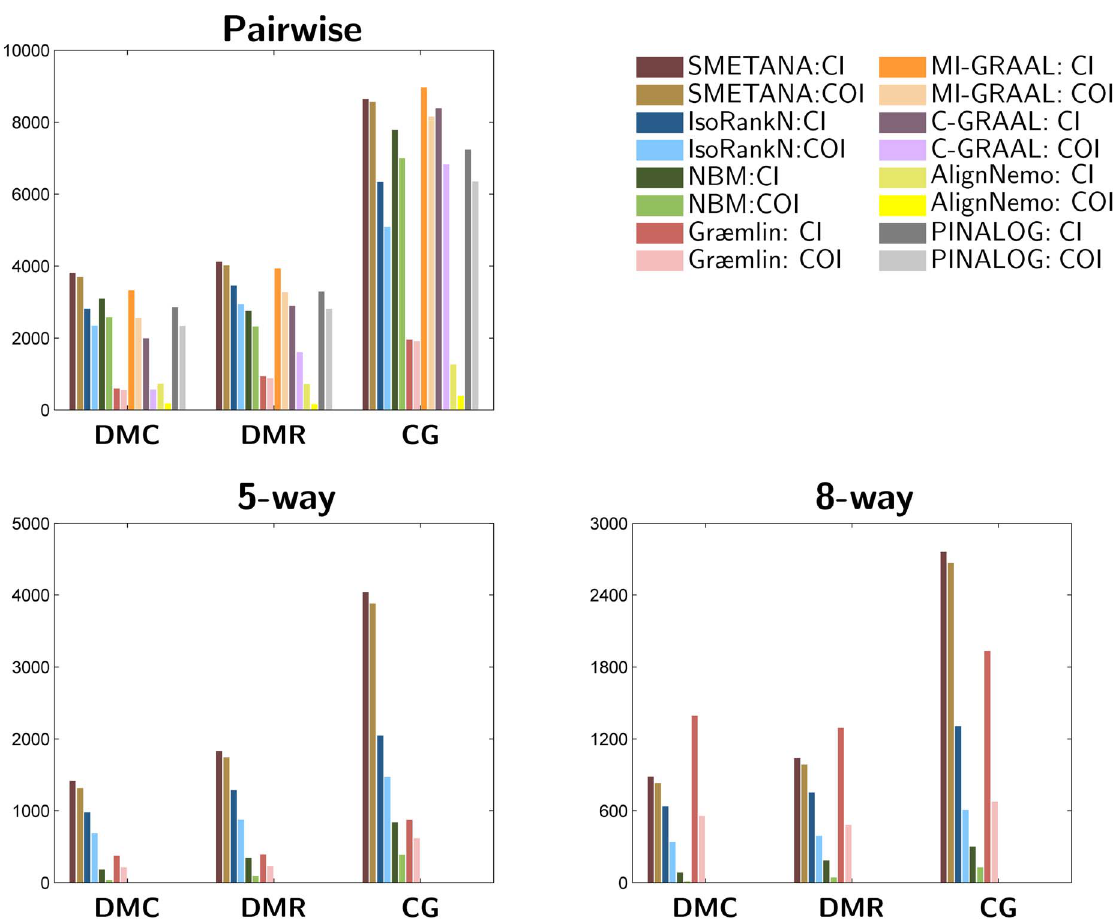
Figure 3. Number of conserved interactions (CI) and conserved orthologous interactions (COI) for different alignments. CI reports the total number of conserved edges between any of the equivalence classes in the alignment. COI reports the total number of conserved edges between ‘‘correct’’ equivalence classes that consist of orthologous nodes.